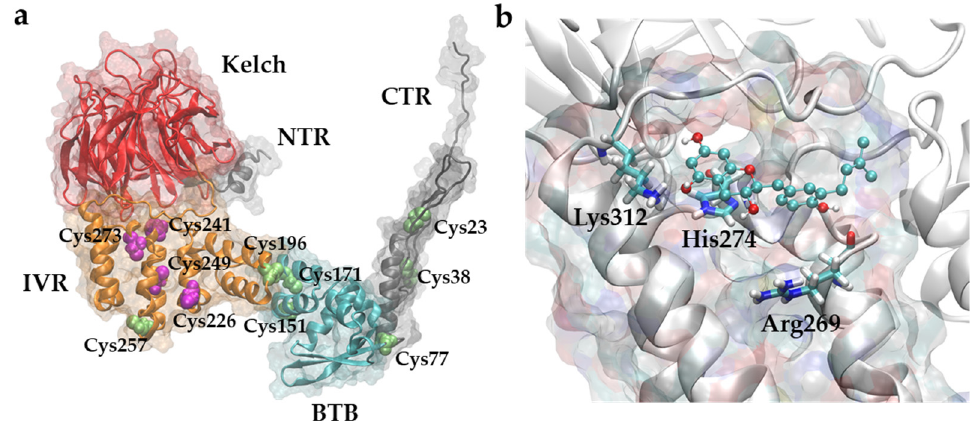
Figure 5. ( a ) A model of full-length KEAP1 predicted by AlphaFold2. A BTB domain (amino acids 61–179) is shown in cyan, an intervening region (IVR, amino acids 180–314) is shown in orange, and a Kelch domain (Kelch) is shown in red. N-terminal (NTR, amino acids 1–60) and C-terminal regions (CTR, amino acids 599–624) are shown in grey. Cysteine residues, which were investigated in the proteomics experiments, are shown in magenta (non-alkylated ones) and lime (alkylated). Domains are designated as in ref. [35]. ( b ) Docking pose of the generated compound (3,5,7-trihydroxy-2-[(4- hydroxy-3-(3-methylbut-2-en-1-yl)phenyl)methyl]-2,3-dihydro-4H-1-benzopyran-4-one), shown as ball-and-stick model) in the region close to Cys273. Positively charged amino acids (Lys312, His274, Arg269) forming the entrance to the cavity are shown. Visualization is made in VMD 1.9.3. [36].